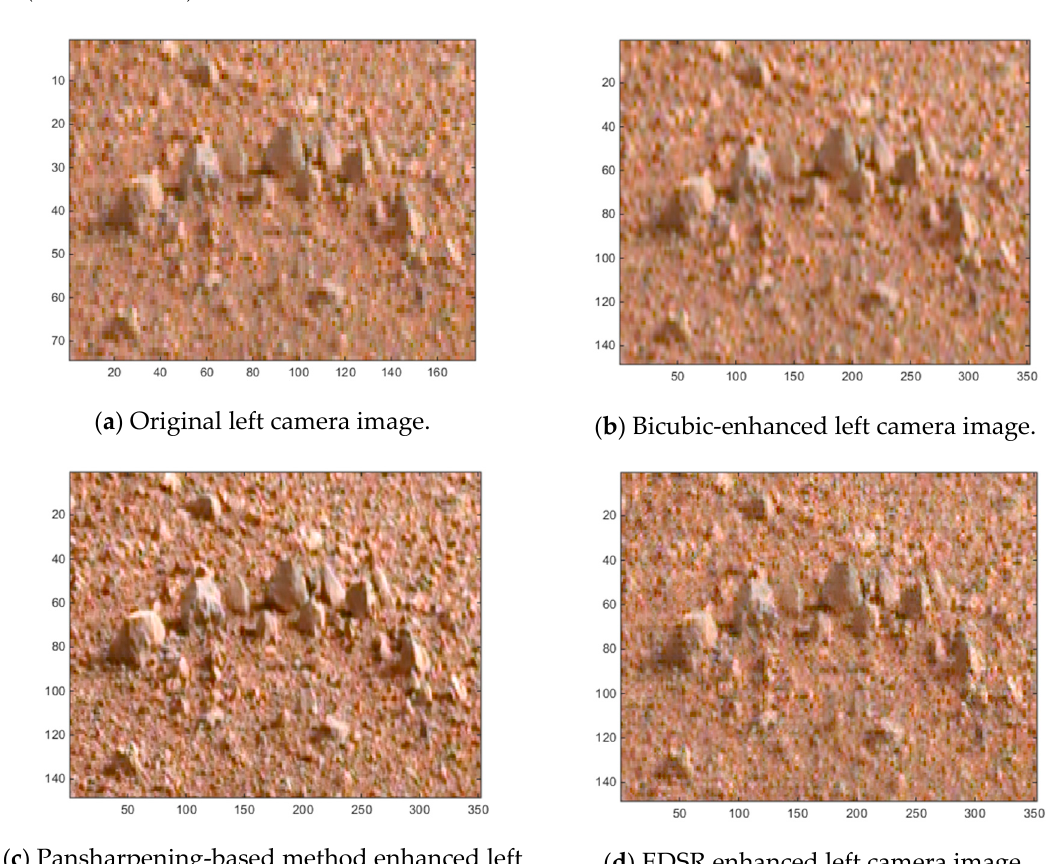
( c ) Pansharpening-based method enhanced left camera image. Figure 16. Image enhancements on the third image Figure 16. Image enhancements on the third image (0023ML0001140700100703C00_DRCX_0PCT.png). 6.2. Disparity Map Estimation Using Enhanced Downsampled Left Mastcam Images